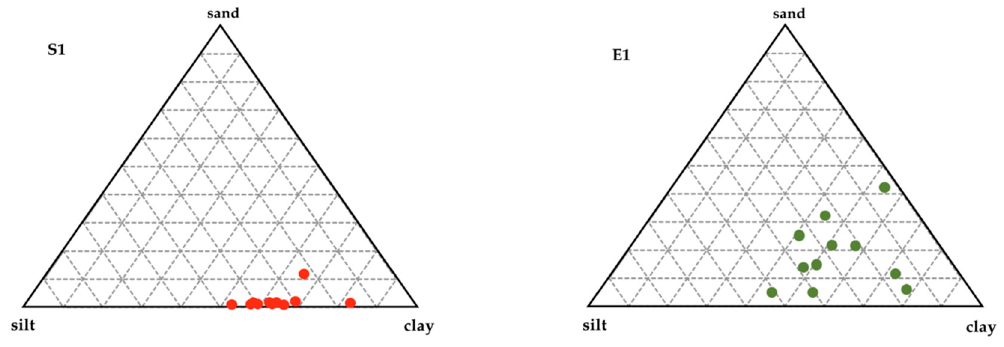
Figure 4. Shepard diagram of the sediment composition in S1 and E1 (cruise ANOC-16) sediment cores.